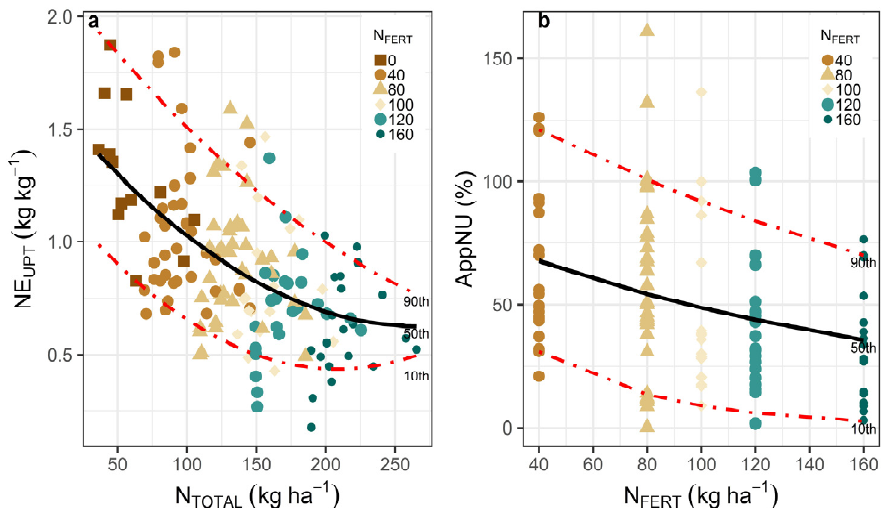
Figure 3. Quantile regression models fitted to different percentiles relating NE UPT (kg kg − 1 ) in response to N TOTAL ( a ) and AppNU (%) in response of N FERT ( b ). Each data point is a plot on a farm with fertilization treatment.